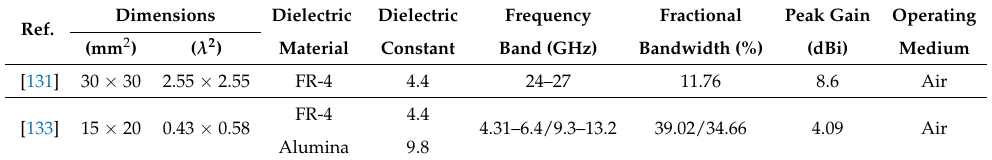
Table 7. Comparative analysis among DRAs meant for near-field microwave imaging.